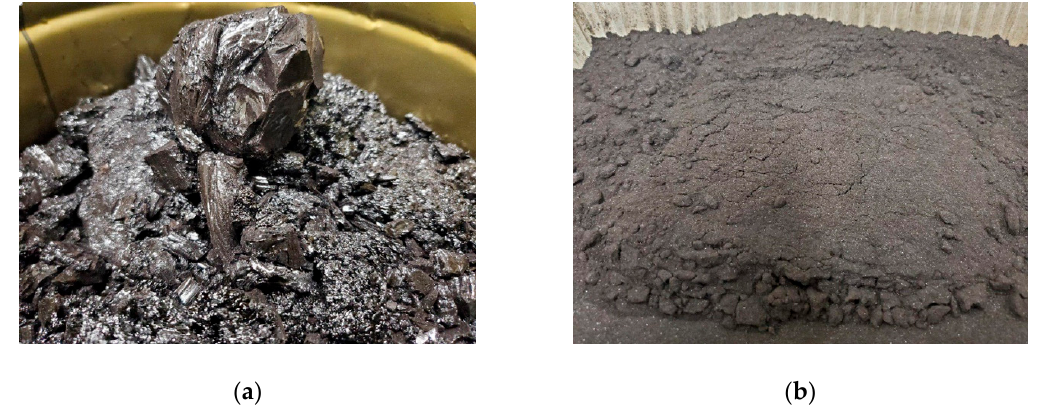
Figure 1. Asphaltenes: ( a ) solid form; ( b ) powder form after passing through a #100 sieve.